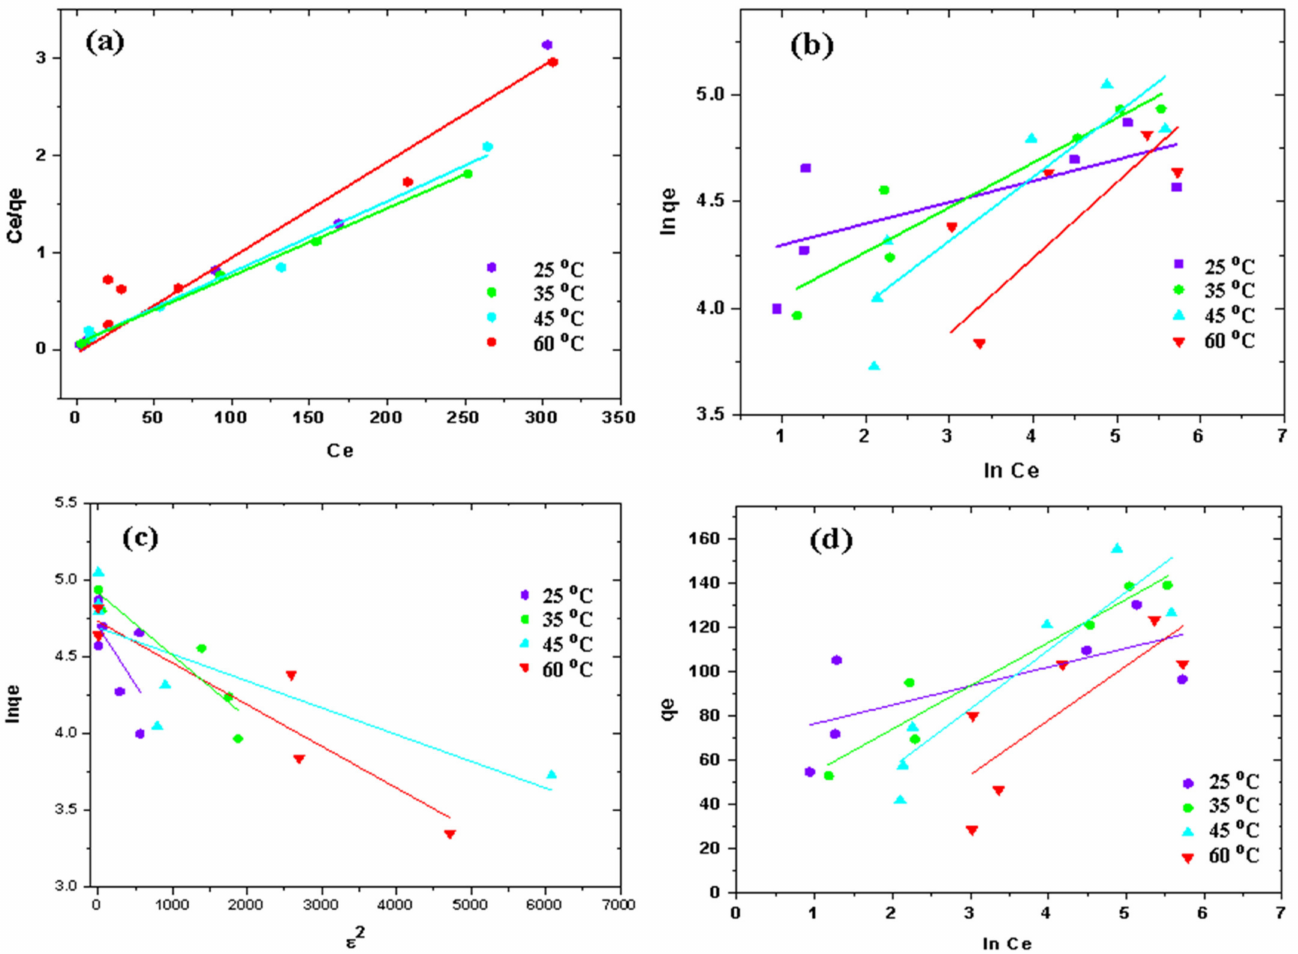
Figure 7. ( a ) Langmuir, ( b ) Freundlich, ( c ) Dubinin–Radushkevich and ( d ) Temkin isotherm for diclofenac adsorption over g-C 3 N 4 /MoO 3 (3%)